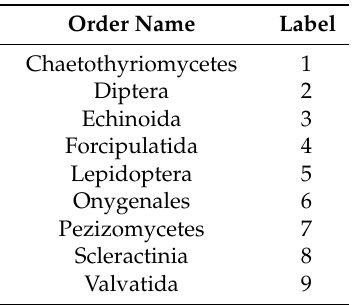
Table 1. Labels used for different classes in the dataset. Order